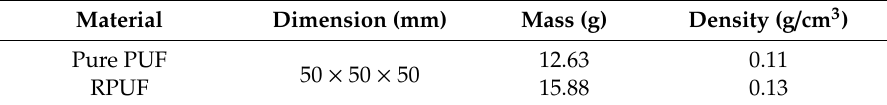
Table 2. Test specimen properties. RPUF—reinforced polyurethane